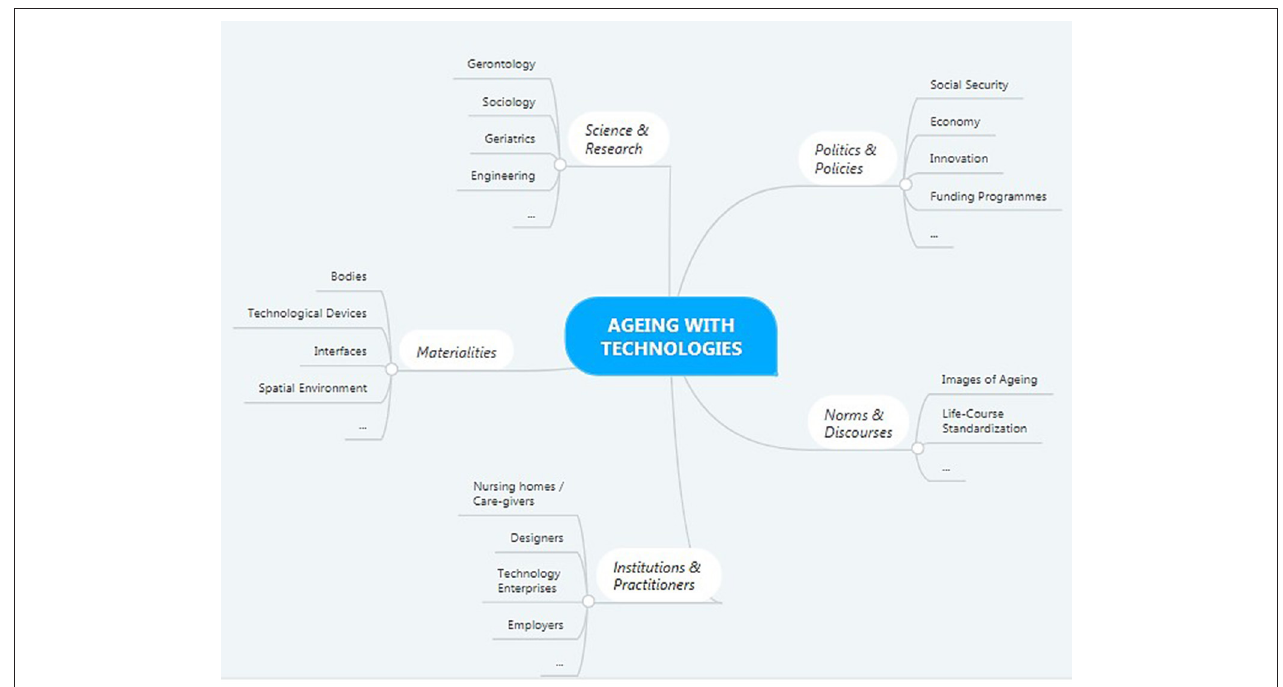
FIGURE 1 | Elements of the field of technologies and